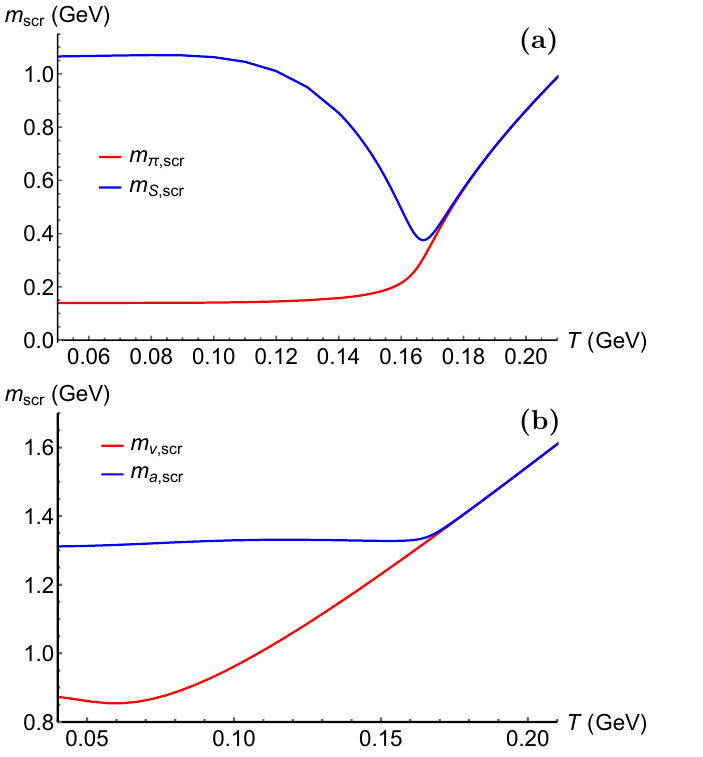
Figure 3 . The temperature dependence of the screening masses with the physical quark mass m q = 3 . 22 MeV. (a) The screening masses of the scalar meson ( m S , scr ) and the pion ( m π, scr ). (b) The screening masses of the vector meson ( m v , scr ) and the axial-vector meson ( m a , scr ). masses equal the meson masses at zero temperature m m ( T = 0) = m ( T = 0) ≈ 1 . 06 GeV. With the increasing of the temperature, S , scr S